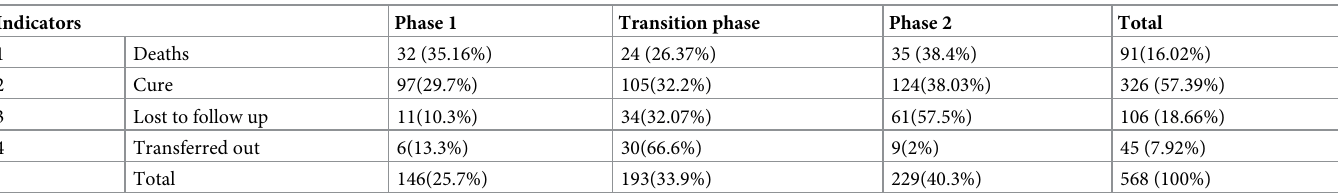
Table 2. Outcomes according to the World Health Organization phases.